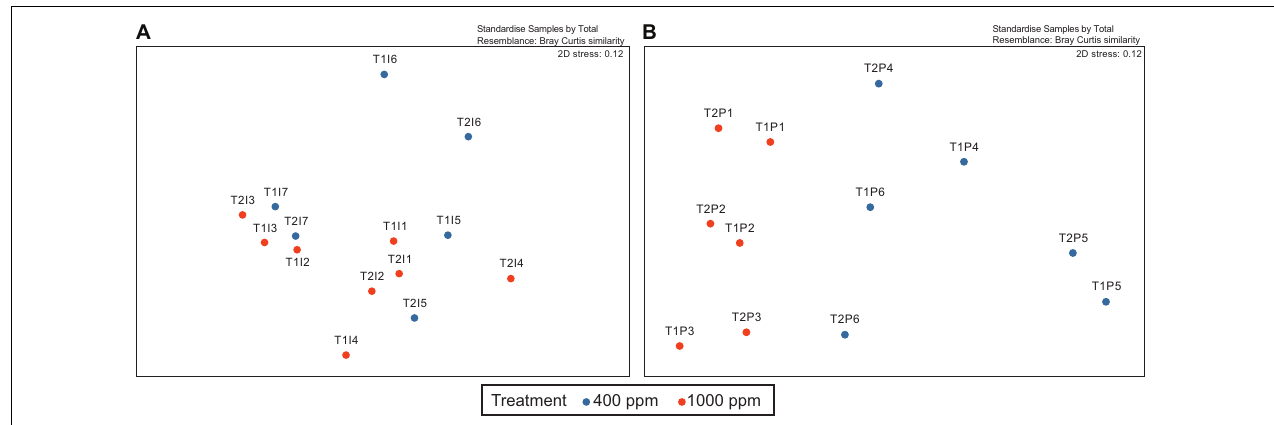
FIGURE 2 | Non-metric multidimensional scaling (nMDS) analysis of the changing endolithic bacterial community in the (A) Isopora palifera and (B) Porites lobata colonies. The blue indicates coral colonies under 400 ppm p CO 2 (control) and the orange indicates colonies under 1,000 ppm p CO 2 . The samples marked as T1 and T2 are represent the first and second sampling times,